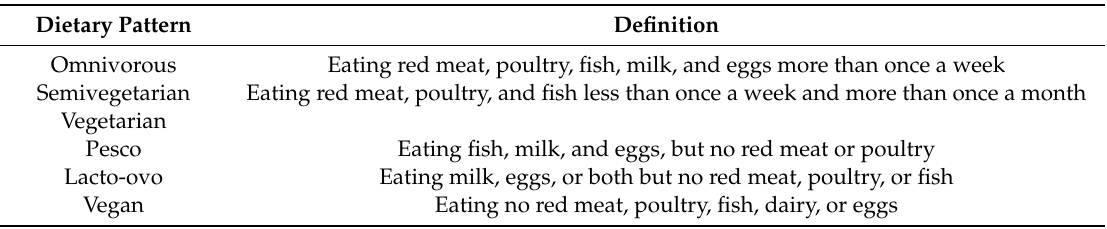
Table 1. Classification of dietary